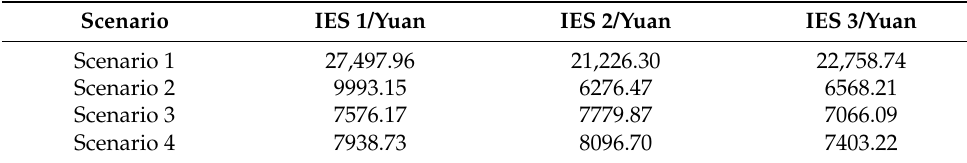
Table 2. Costs of three gas–electric